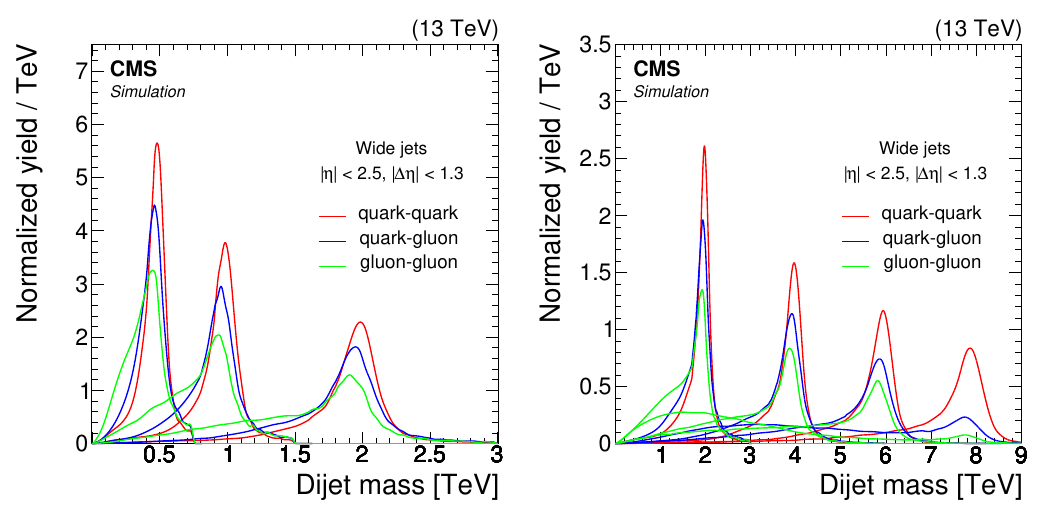
Figure 8 . Signal shapes of narrow resonances with masses of 0.5, 1, and 2 TeV in the low-mass search (left) and masses of 2, 4, 6, and 8 TeV in the high-mass search (right). These reconstructed dijet mass spectra show wide jets from the pythia 8 MC event generator including simulation of the CMS